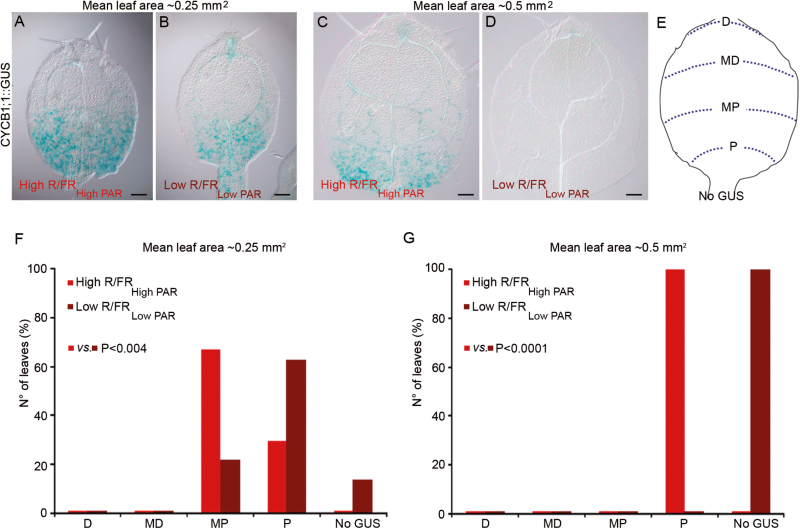
Shade affects the spatial expression pattern of the CYCB1;1:GUS marker in the leaf. (A–D) Histochemical localization of GUS activity in the adaxial subepidermal cells of the first and second leaves of CYCB1;1:GUS seedlings grown in a light/dark cycle (16/8 h) for 7.5 d (A) and 8.5 d (C) in High R/FRHigh PAR (High R/FRHigh PAR), or for 4 d in High R/FRHigh PAR and subsequently for 5 d (B) and 6 d (D) in Low R/FRLow PAR (Low R/FRLow PAR), respectively. First and second leaf area (mean ±SE): (A) 0.25 ± 0.011 mm2; (B) 0.24 ± 0.009 mm2; (C) 0.53 ± 0.013 mm2; (D), 0.54 ± 0.012 mm2. Scale bars: 100 μm. (E–G) Quantification of the CYCB1;1:GUS expression pattern in different regions of the first and second leaf blade. For each condition, at least 10 leaves were analysed and divided into four GUS expression patterns, depending on the extension of the blue signal along the proximo-distal axis, indicated as distal (D), median–distal (MD), median–proximal (MP), and proximal (P). No GUS refers to those leaves in which the GUS staining has completely withdrawn from the blade (E). The numbers in the graphs indicate the percentage of leaves falling into each expression pattern, in the specified light conditions (F, G).